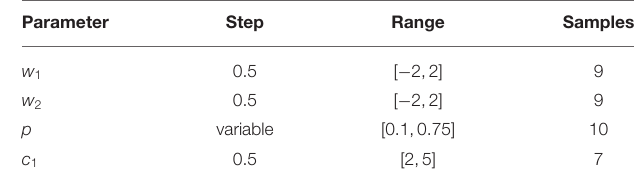
TABLE 1 | Sampling of the geometrical and mechanical parameters used to generate training and testing dataset.